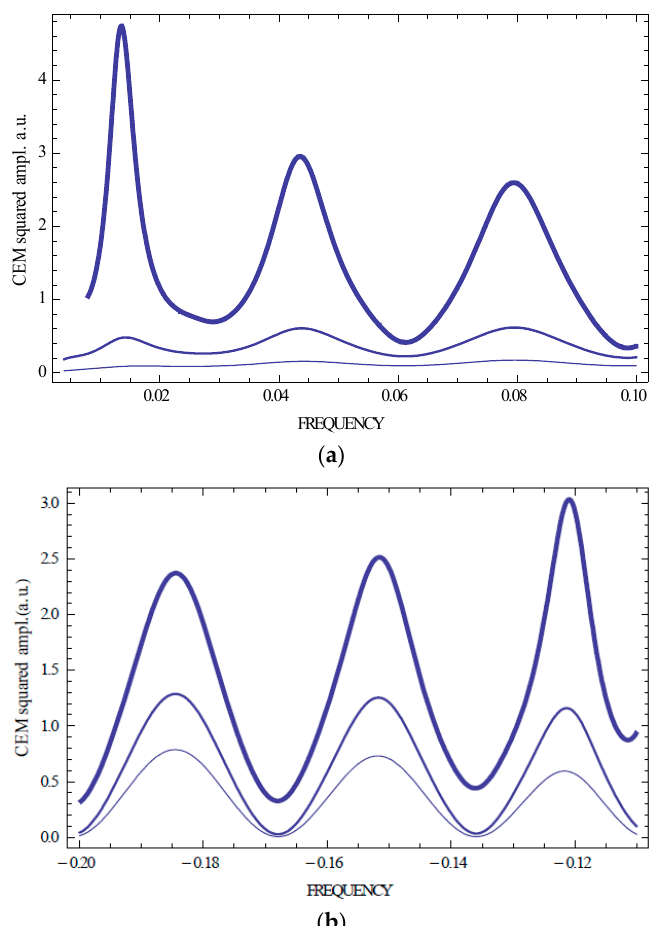
Figure 4. Calculated squared CEM amplitude for non-absorbing and isotropically absorbing CLC layer [ δ (1 + sin θ )/2 = 0.05, thickness in period number N = 100, γ = 0, 0.003, 0.006 (shown at decreasing line thickness)], at the high frequency ( a ) and low frequency ( b ) stop band edge for three first CEMs (n = ±1, ±2, ±3).